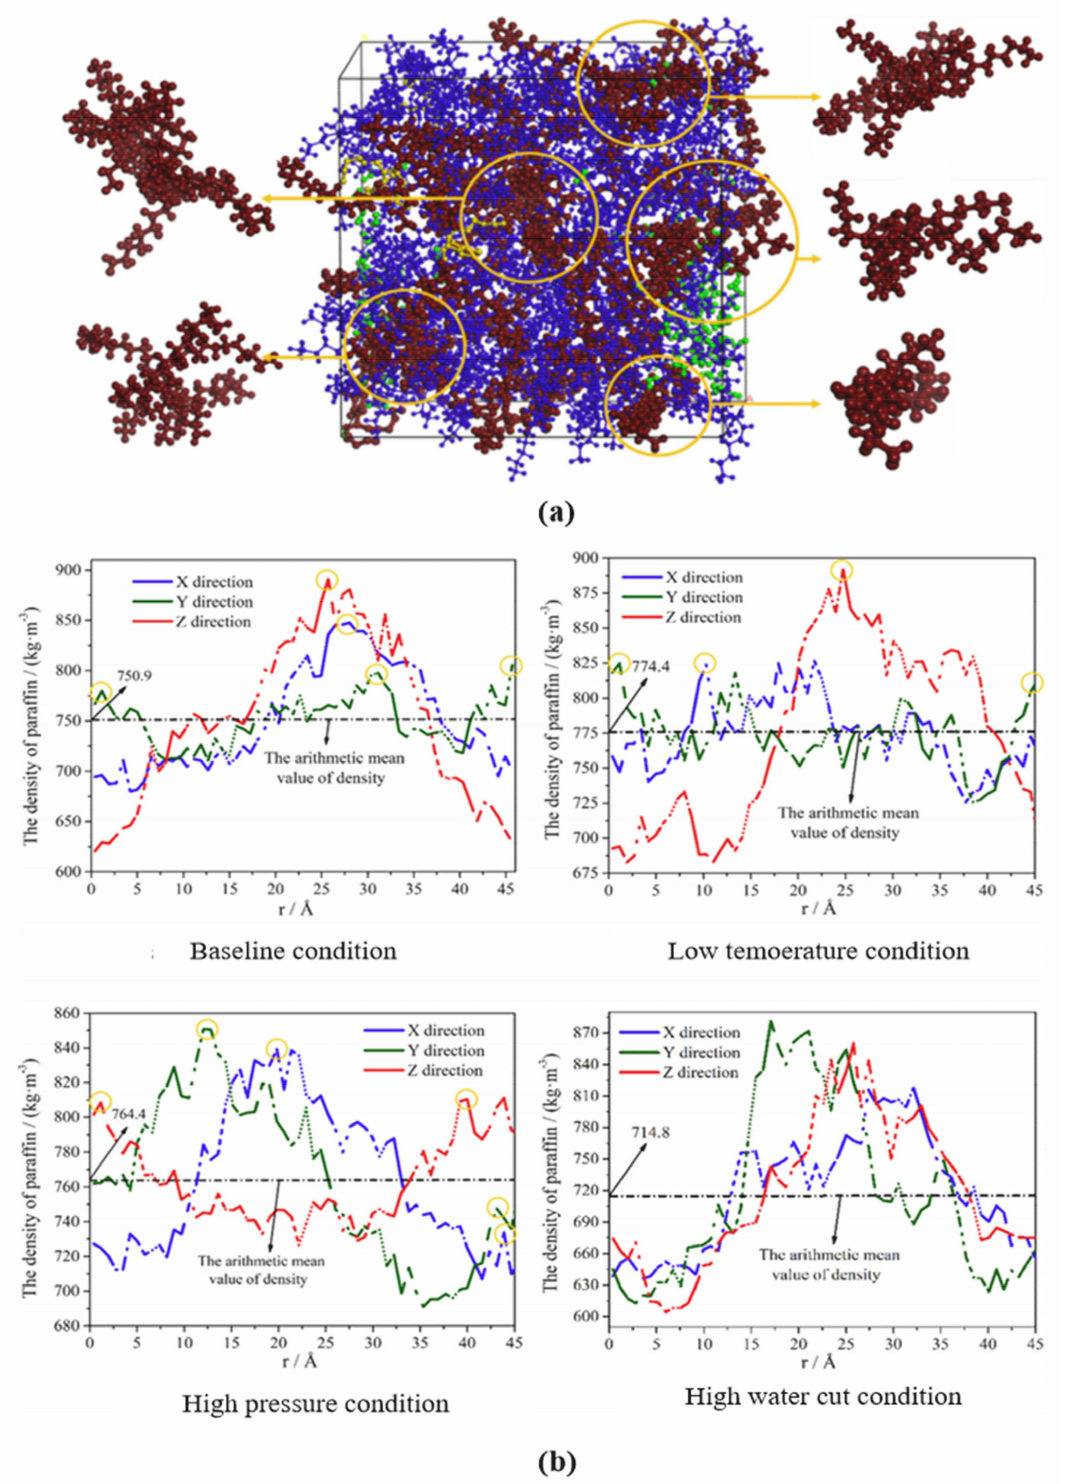
Figure 9. Schematic diagram of the final configuration of wax precipitation and density distribution of wax molecules in all directions. ( a ) final simulated configuration and ( b ) wax molecular density in X, Y and Z directions under different conditions